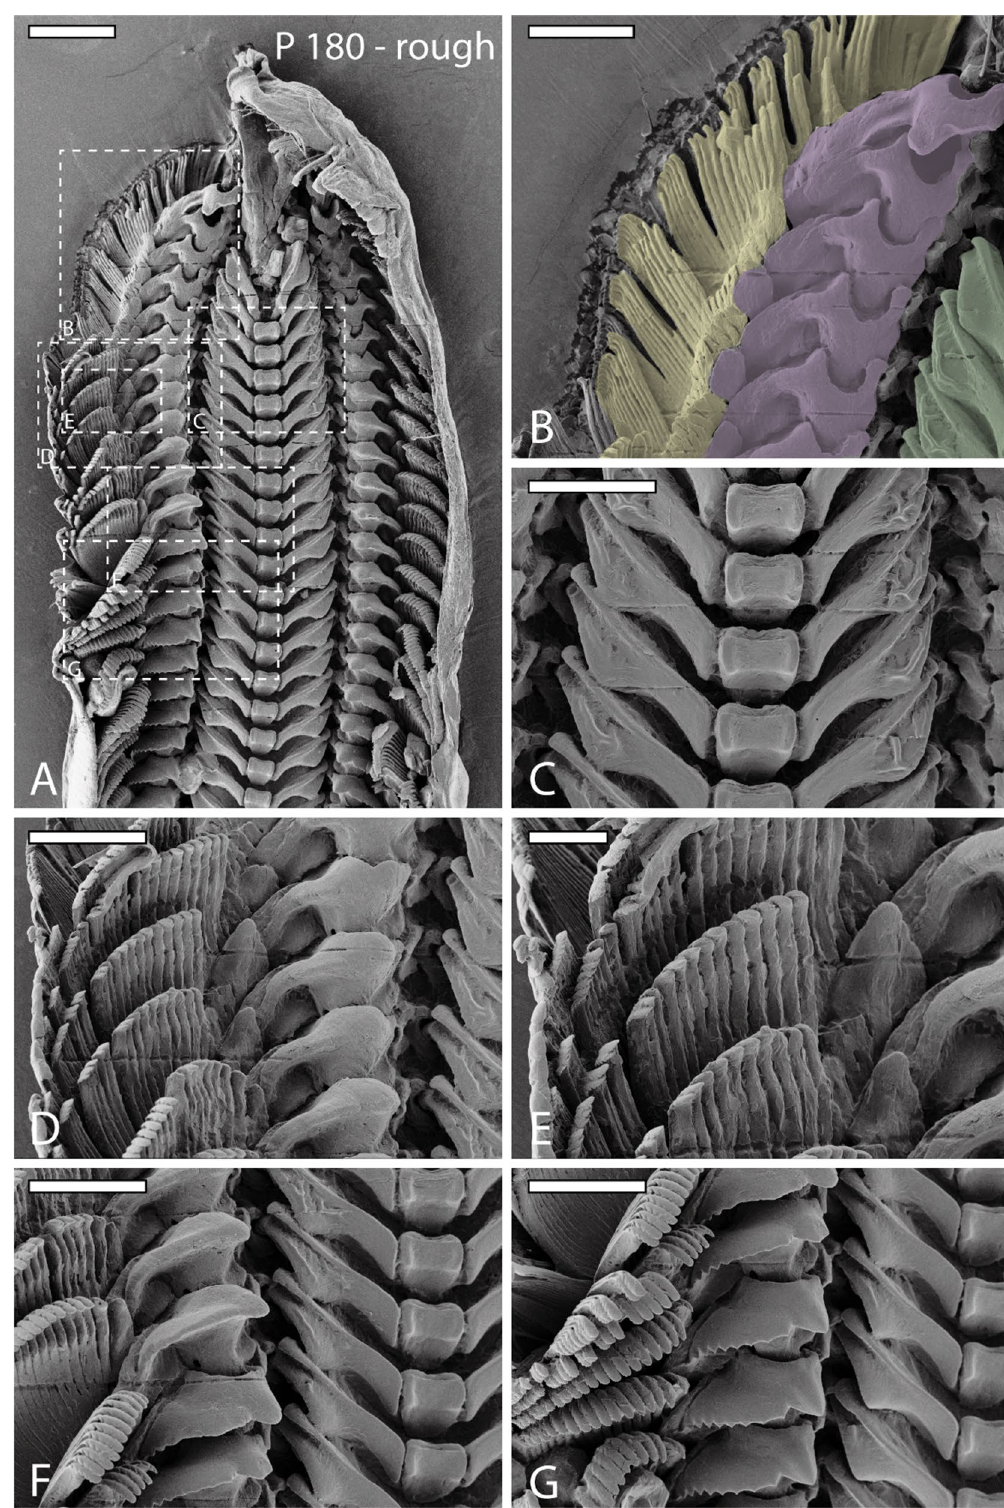
Figure 5. SEM images of one radula from specimen sheltered on rough sandpaper (P 180). ( A ) Image of outermost part of radula (wear and digestive zone). ( B – G ) Magnifications of same region as in ( A ). ( B ) Right wear zone with colored outlines of lateral teeth I (green), lateral teeth II (purple), and 15 inner marginal teeth (yellow; only marginal teeth that show signs of wear were colored). ( C ) Worn lateral teeth I and unworn central teeth. ( D – E ) Worn lateral teeth I, lateral teeth II, marginal teeth. ( F ) Slight signs of wear. ( G ) First signs of wear on lateral tooth I, lateral tooth II, and marginal teeth. Scale bars: A = 200 μm, B–G = 100